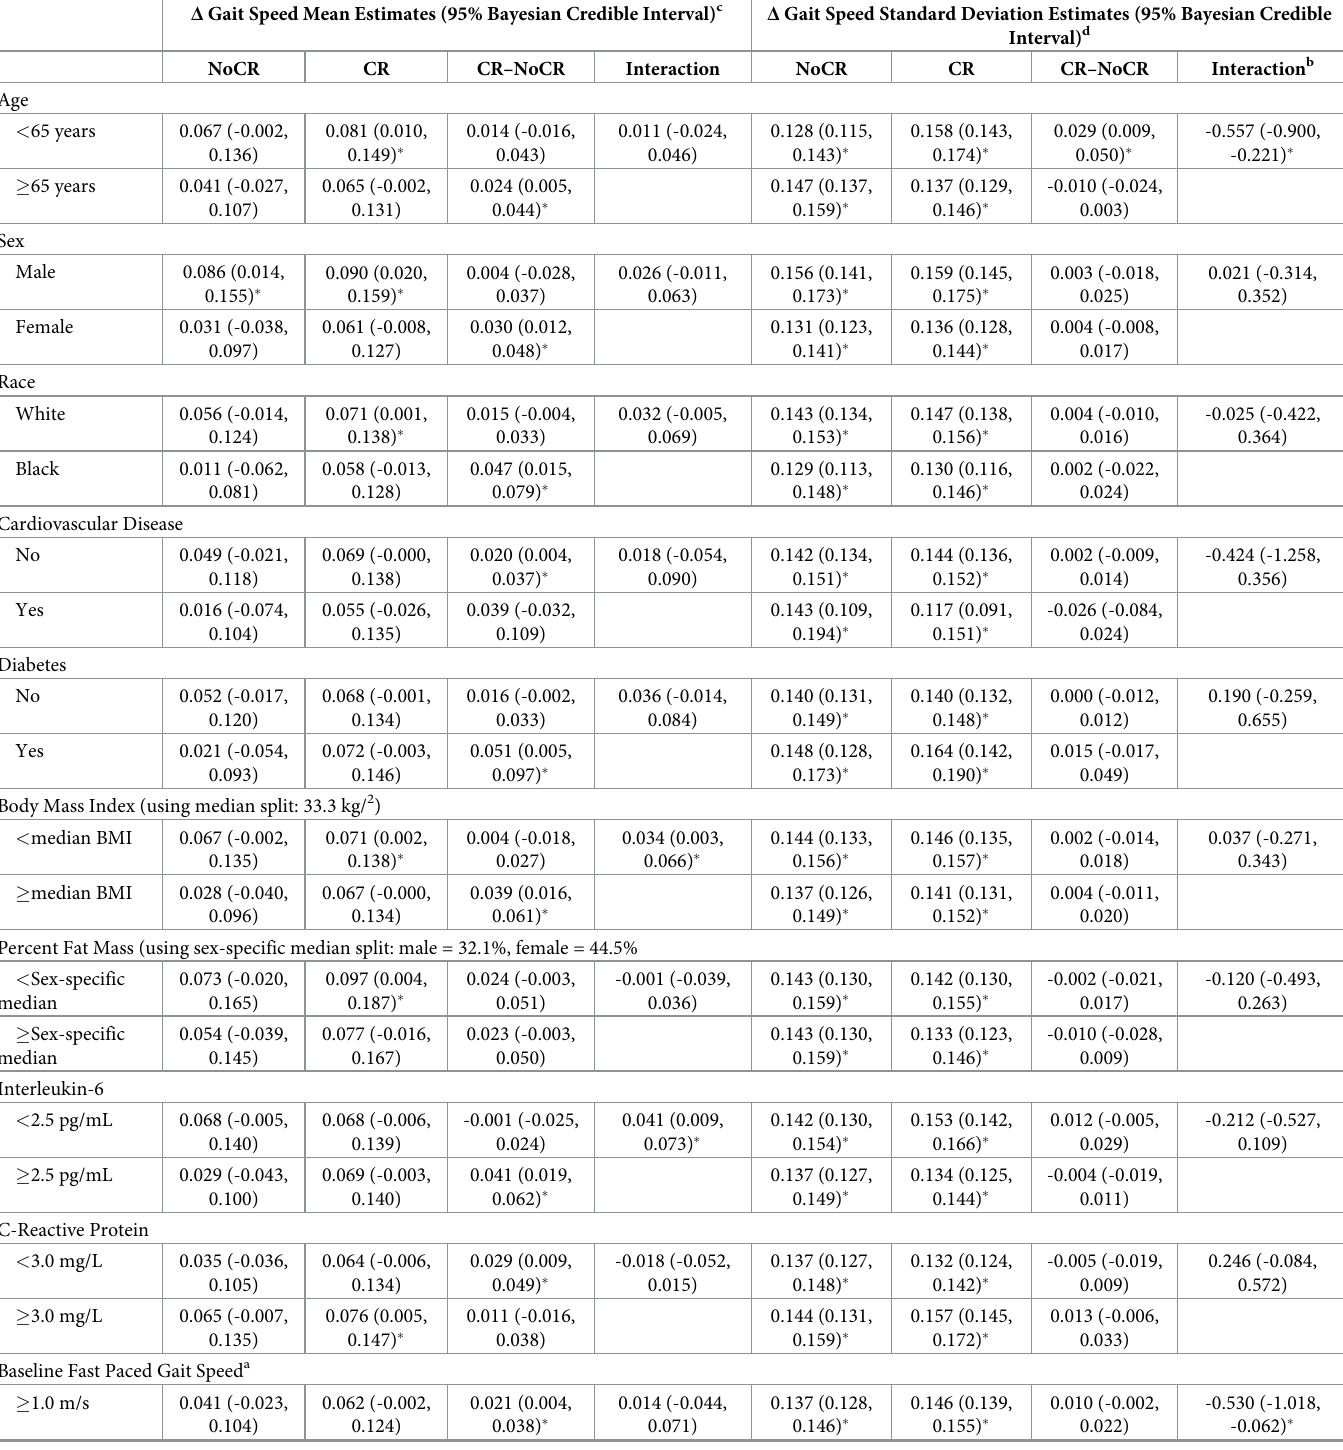
Table 3. Subgroup mean and standard deviation estimates in gait speed change, presented by treatment group and after fitting an interaction